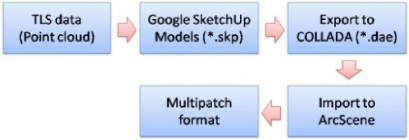
Figure 11. Process from point cloud data to GIS-ready models